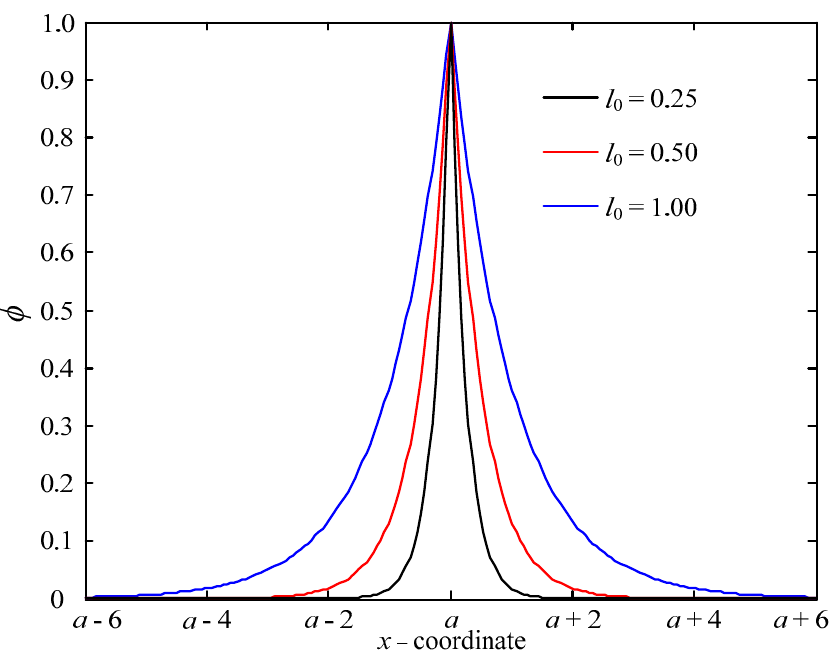
Figure 1. Distribution of phase-field function.